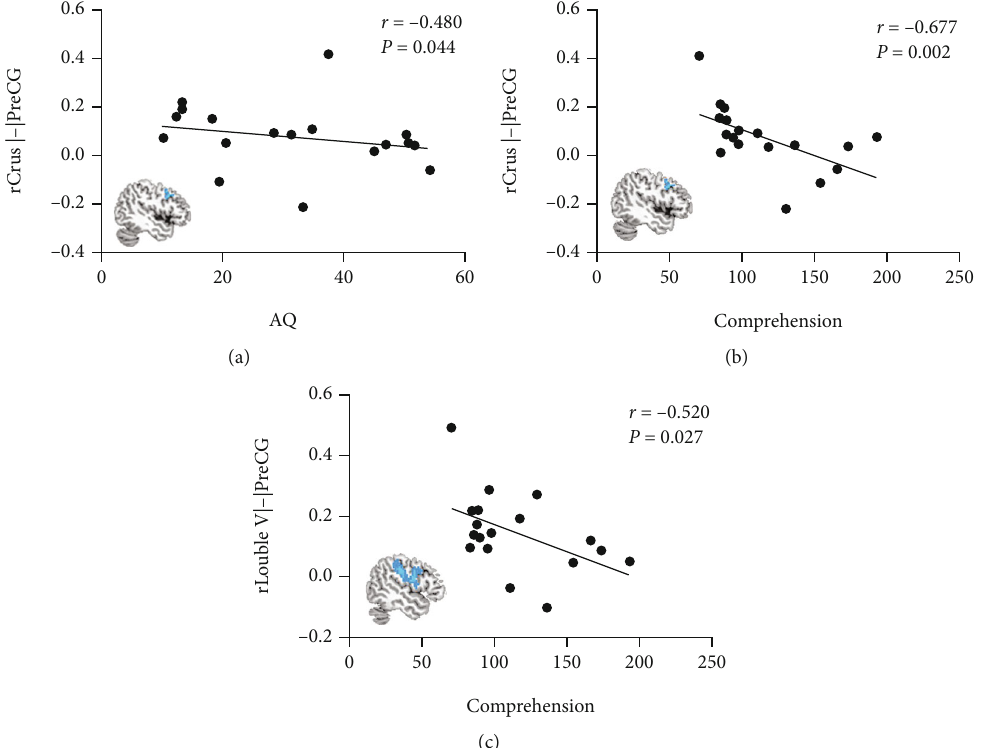
Figure 6: (a) Negative correlation between rCrus I-lPreCG and AQ scores ( r = − 0 : 480 , p = 0 : 044 ). (b) Negative correlation between rCrus I-lPreCG and comprehension scores ( r = − 0 : 677 , p = 0 : 002 ). (c) Negative correlation between rLobule VI-lPreCG and comprehension scores ( r = − 0 : 520 , p = 0 : 027